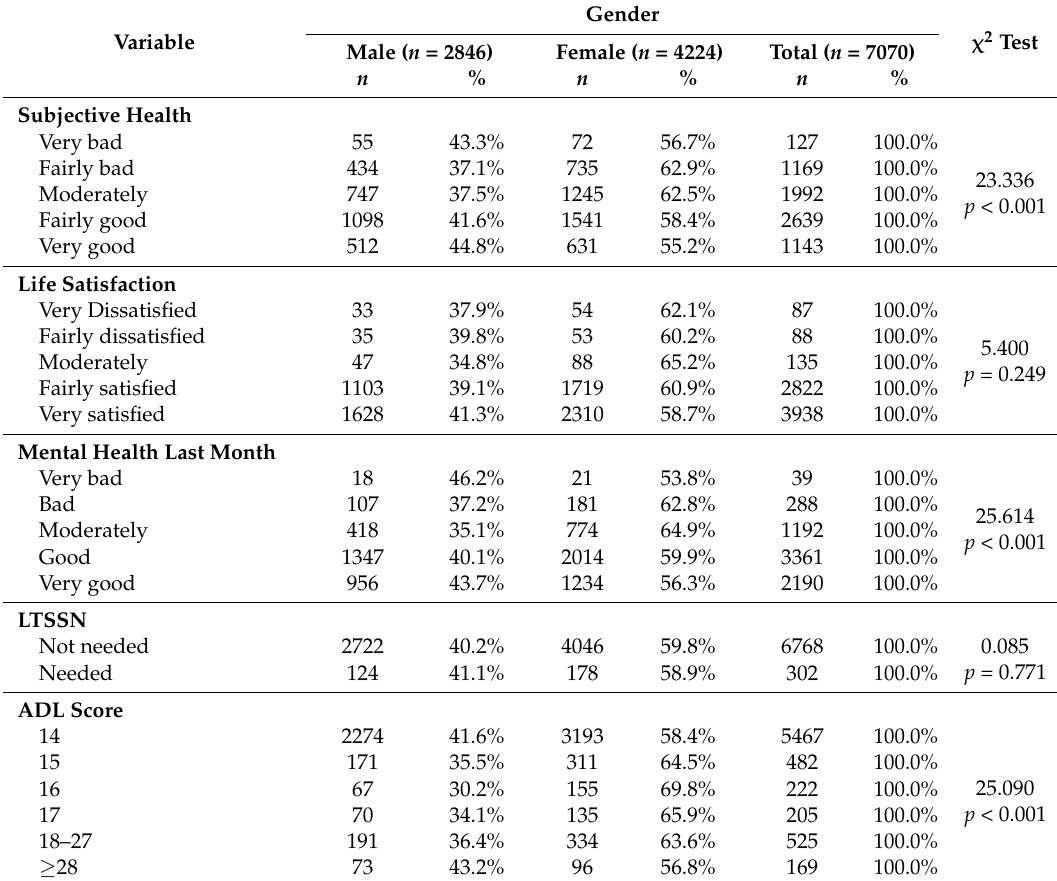
Table 4. Descriptive Mental Health and NLTSS (the need for long-term services and support) Characteristic of Participants by